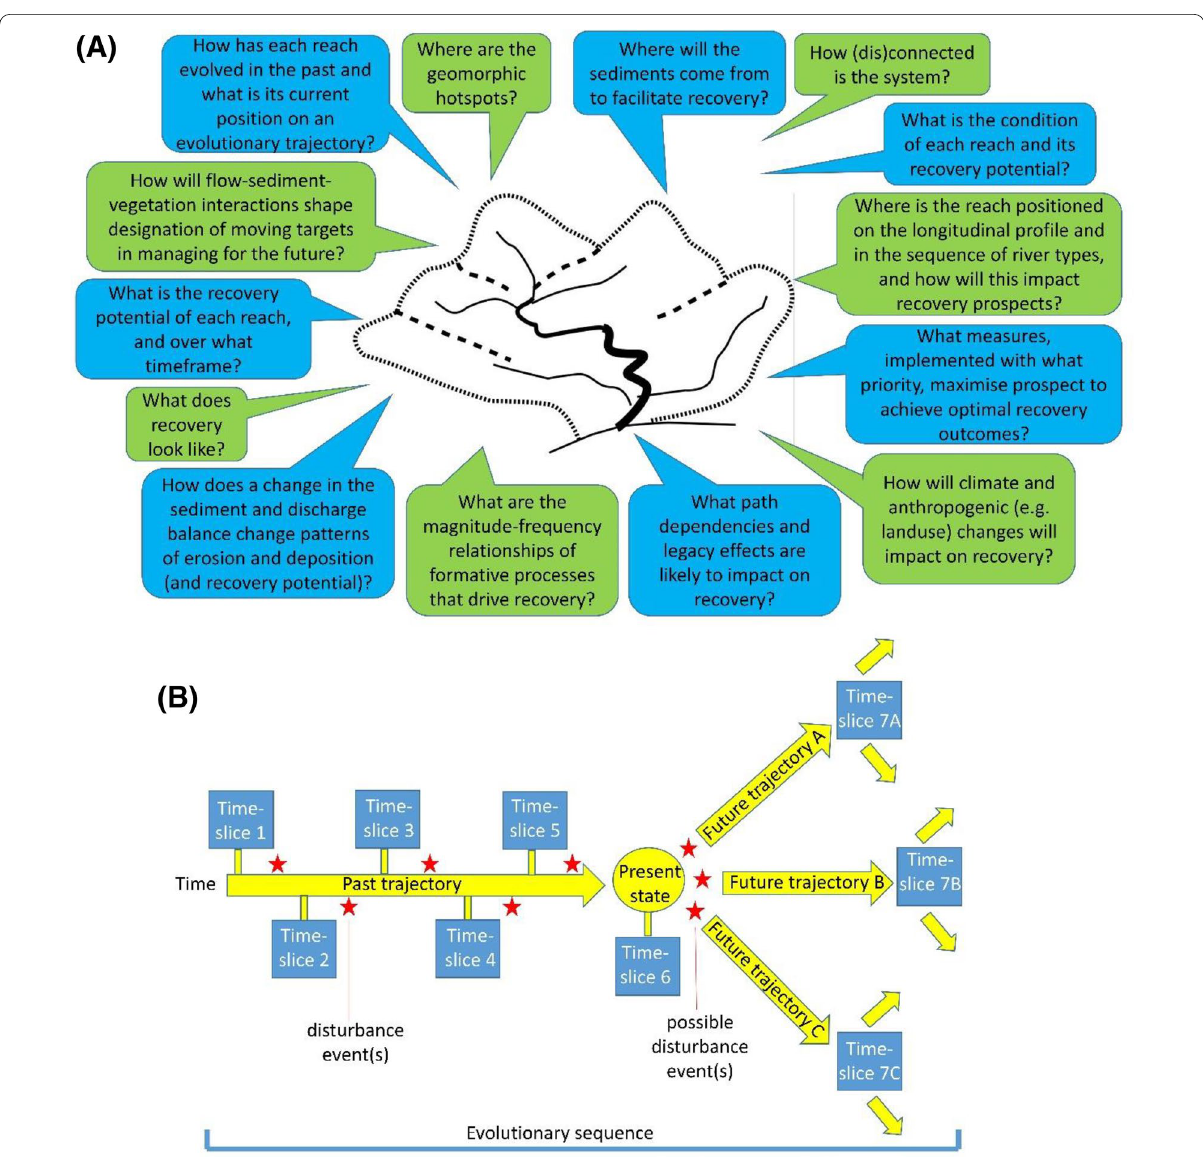
Fig. 7 Spatial and temporal components of evolutionary trajectory analyses inform interpretations of river recovery and determination of moving targets for management. A Sediment (dis)connectivity relations and changing sediment flux conditions at the catchment scale influence prospective river futures (Brierley and Fryirs 2016). B Evolutionary trajectory and future trajectory set moving targets for management (Poeppl et